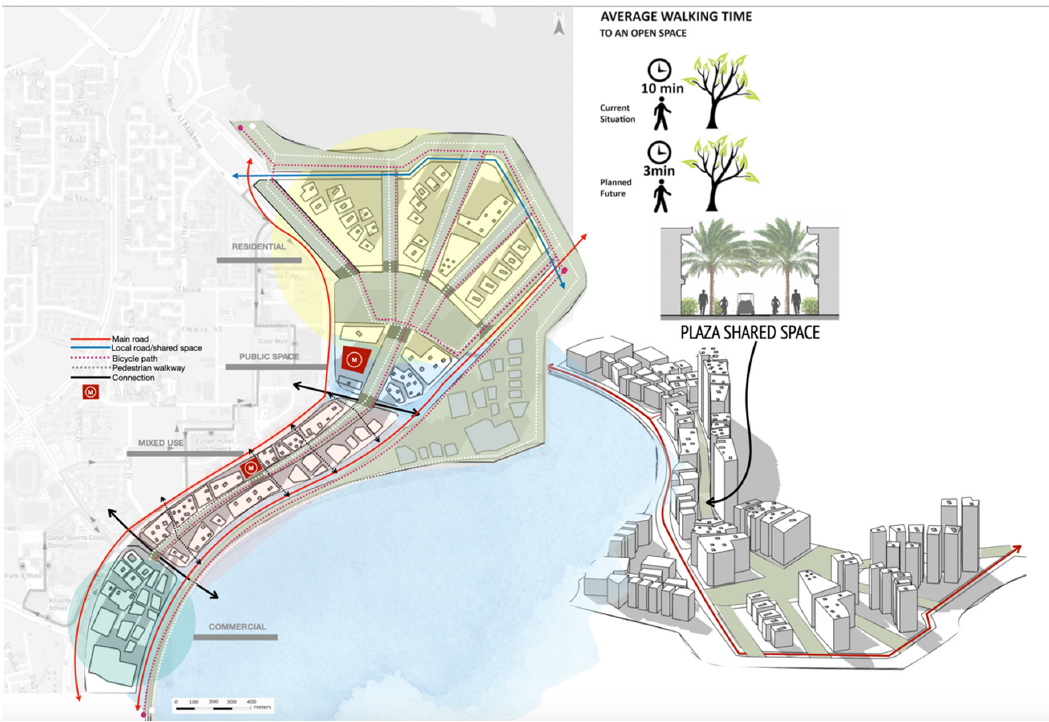
Figure 13. Proposed master plan for the West Bay area.